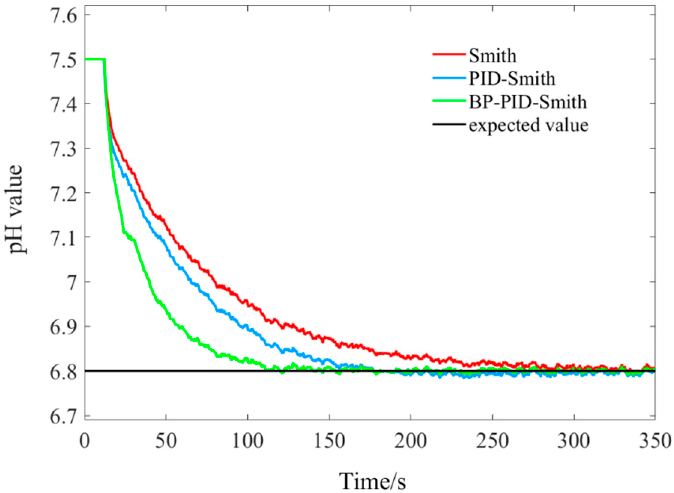
Figure 17. Regulation curves of three controllers for a fertilizer flow rate of 0.35 m 3 /h.